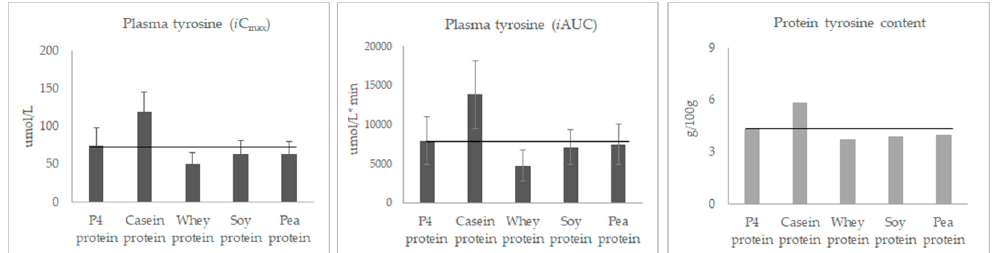
Figure 3. ( a ) Post-prandial plasma i C max and i AUC for essential amino acids. ( b ) Post-prandial plasma Figure 3. (a) Post-prandial plasma i C max and i AUC for essential amino acids. (b) Post-prandial plasma i C max and i AUC for non-essential amino acids (mean ± i C max and i AUC for non-essential amino acids (mean ± SD).